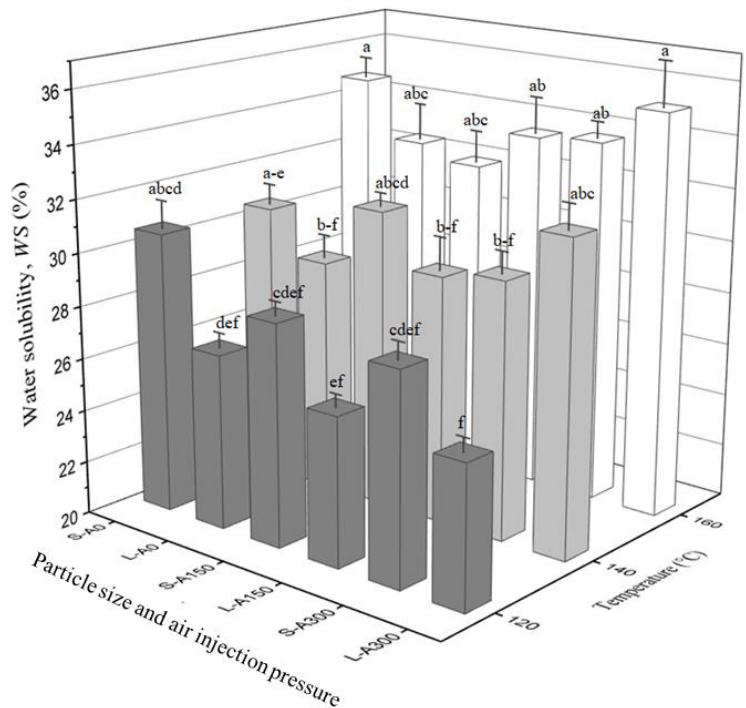
Figure 2. Water solubility ( WS ) values of yellow pea extrudates produced with air injection at 0 kPa, 150 kPa and 300 kPa, i.e., A0, A150 and A300, and two different flour particle sizes, i.e., small (S) and large (L), as a function of die temperature. Values marked with different letters are significantly different ( p ≤ 0.05). Error bars represent ± standard error ( n = 4).